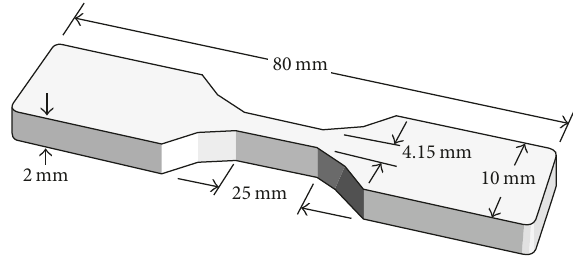
Figure 1: Dimensions of the tensile testing sample.